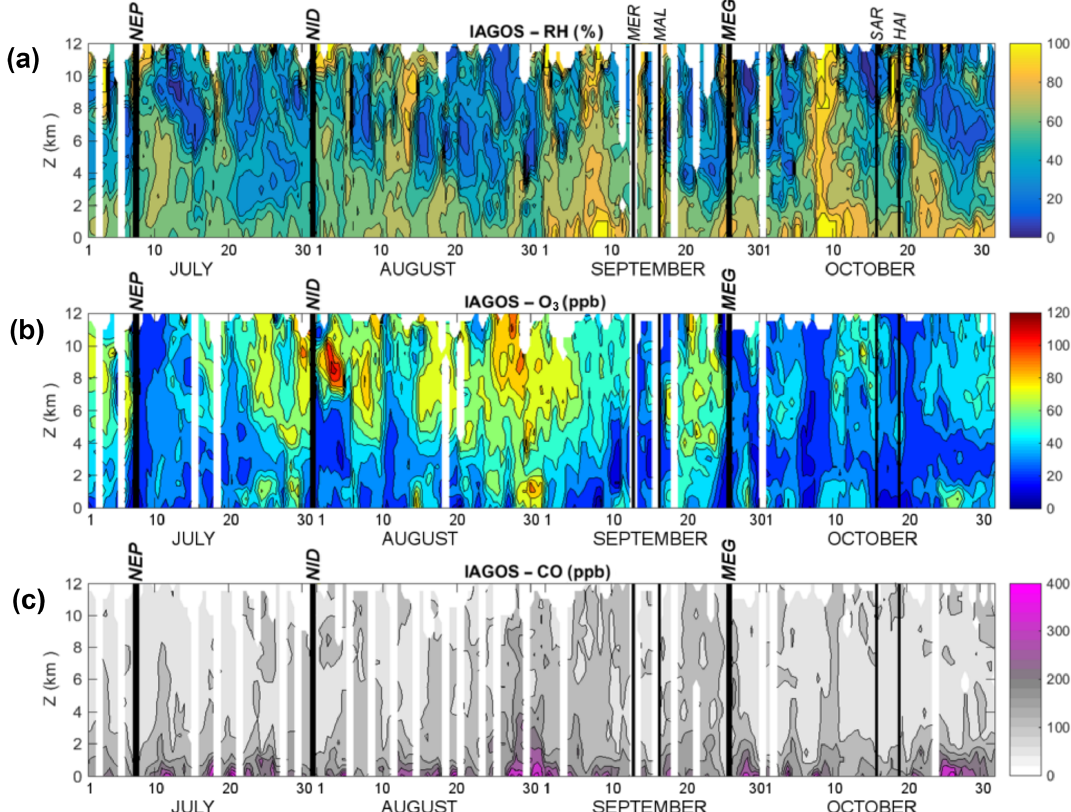
Figure 2. Vertical profiles derived from IAGOS measurements during take-off from and landing to TPE (Taoyuan International Airport; 25.076 ◦ N, 121.224 ◦ E) from 1 July to 31 October 2016 for (a) relative humidity (in %), (b) ozone mixing ratio (in parts per billion by volume – ppbv) and (c) carbon monoxide (in ppbv). Vertical black lines labelled NEP, NID, MER, MAL, MEG, SAR and HAI represent the closest approaches of typhoons Nepartak, Nida, Meranti, Malakas, Megi, Sarika and Haima,